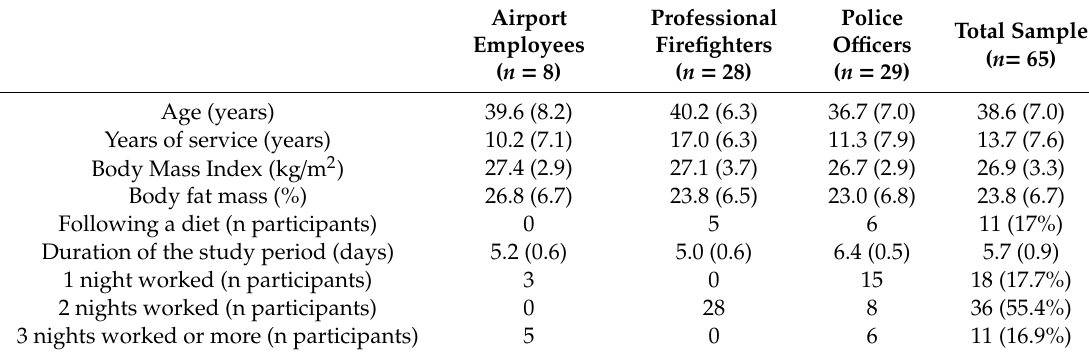
Table 1. Participants’ characteristics (mean ± SD) by worksite and for the total sample.